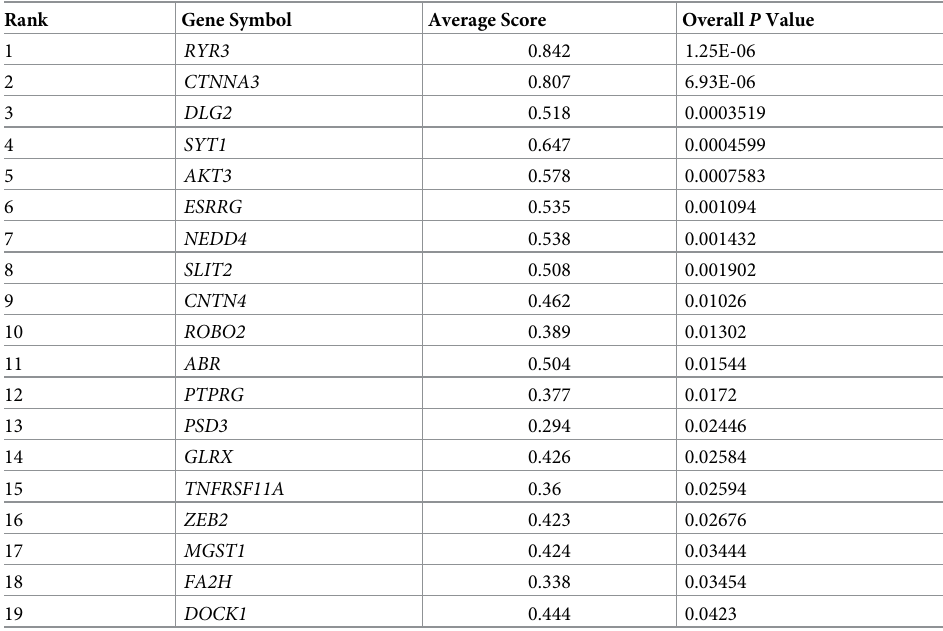
Average score : an overall score combining similarity scores from individual feature using statistical meta-analysis. Overall P value : statistical significance values of average